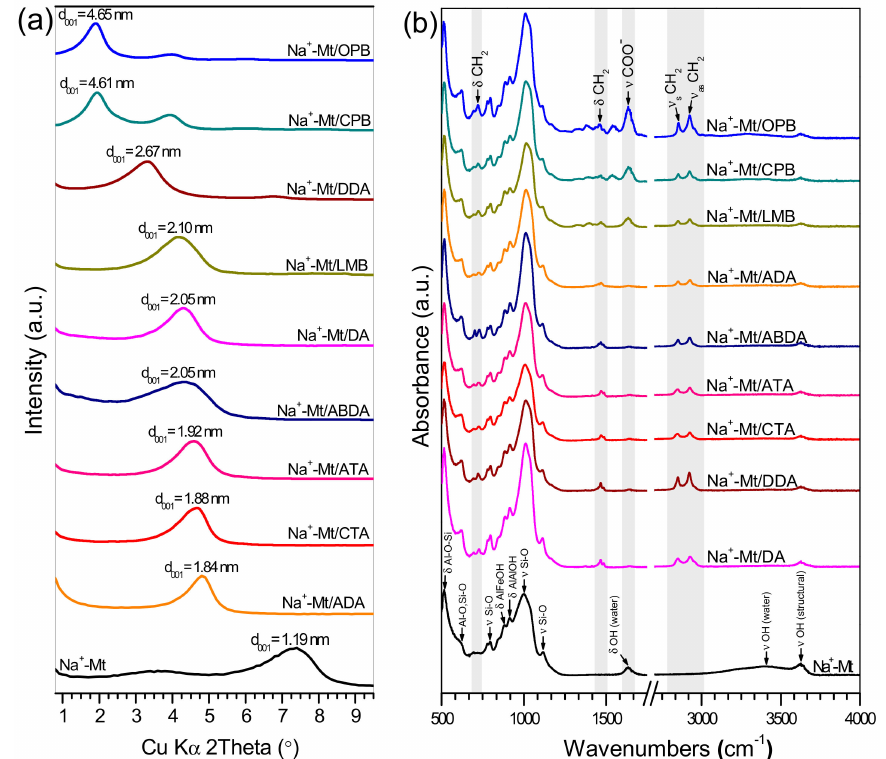
Figure 2. ( a ) XRD patterns and ( b ) attenuated total reflection-Fourier transform infrared (ATR / FTIR) spectra of sodium montmorillonite (Na + -Mt) and its organomodified forms with di ff erent surfactants.